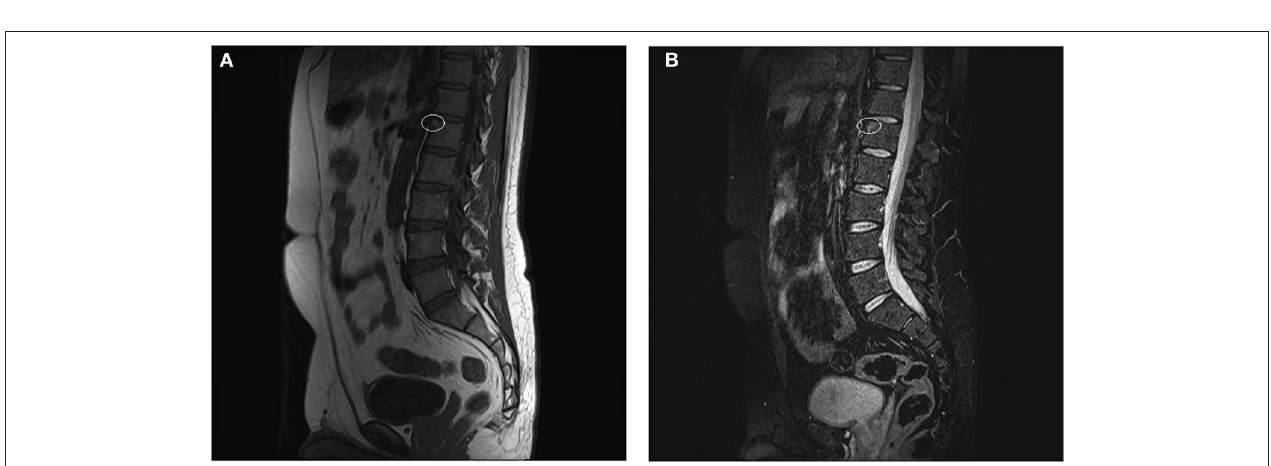
FIGURE 1 | (A,B) : Bone marrow oedema (BMO) signs at both SIJ. (A) hypointense signal at the sacral and iliac superior and inferior third region of both right and left SIJ in sequence T1. (B) corresponding iperintense signal at the sacral and iliac superior and inferior third region of both right and left SIJ in sequence STIR. The written informed consent was obtained from the individual for the publication of these images.